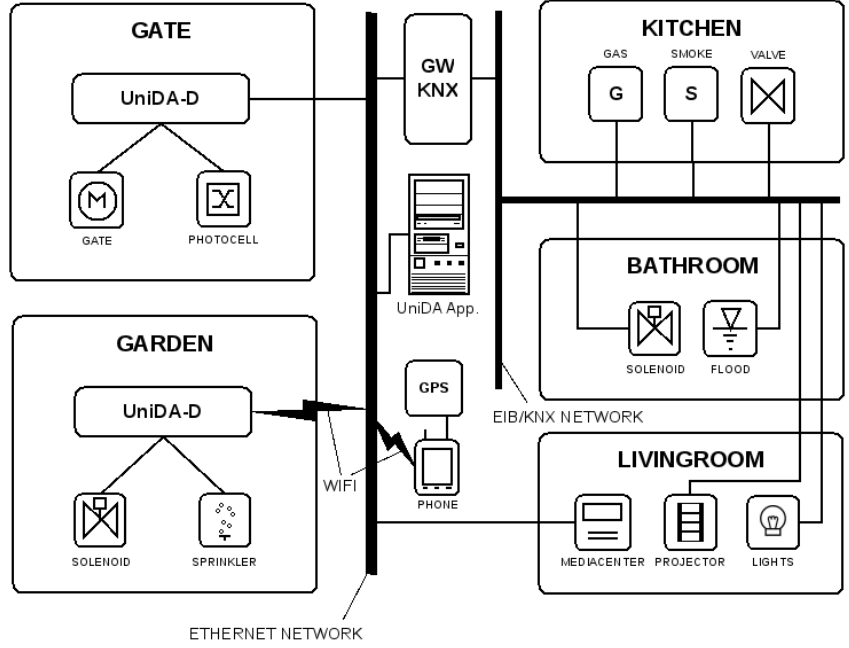
Figure 6. Test environment deployment including